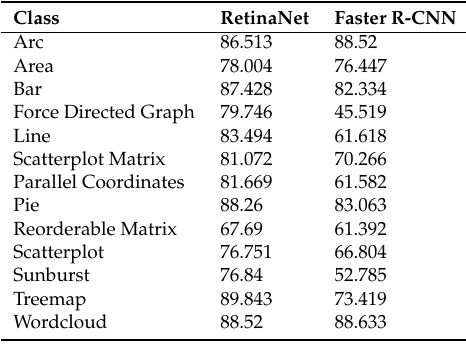
Table 5. Average Precision (AP) values for each class in RetinaNet and Faster R-CNN. RetinaNet has the best class AP for all class besides arc and